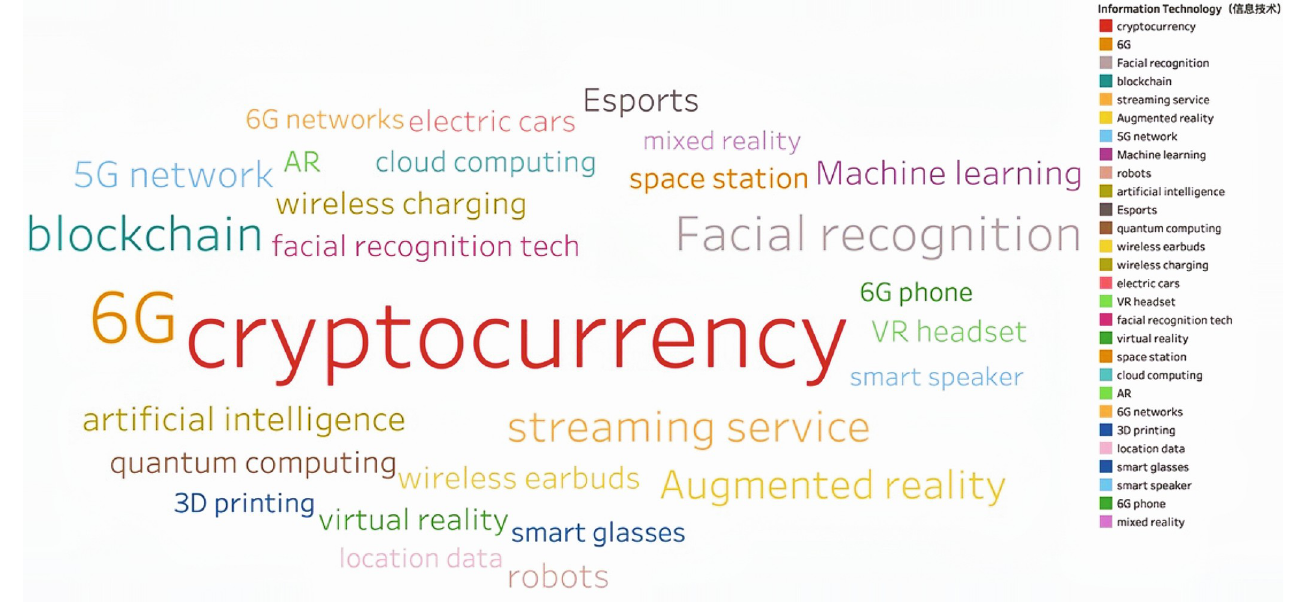
Fig 2. Word cloud diagram in the field of Information